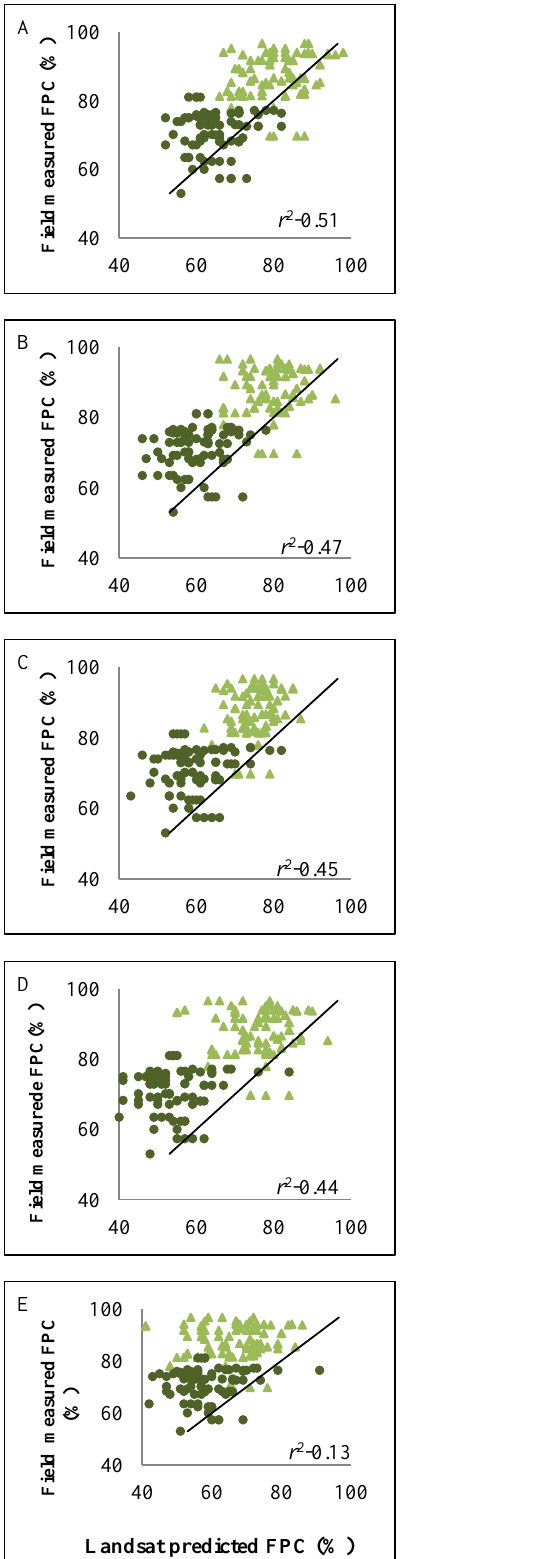
Figure 4. The relationship between field estimated overstorey FPC and high sun angle TM5 predicted overstorey FPC: A- PSSSR, B- SCS+C correction, C- C correction, D- Minnaert correction and E- SCS correction. Symbols denote study area in BRNP (triangles) and RRNP (circles)